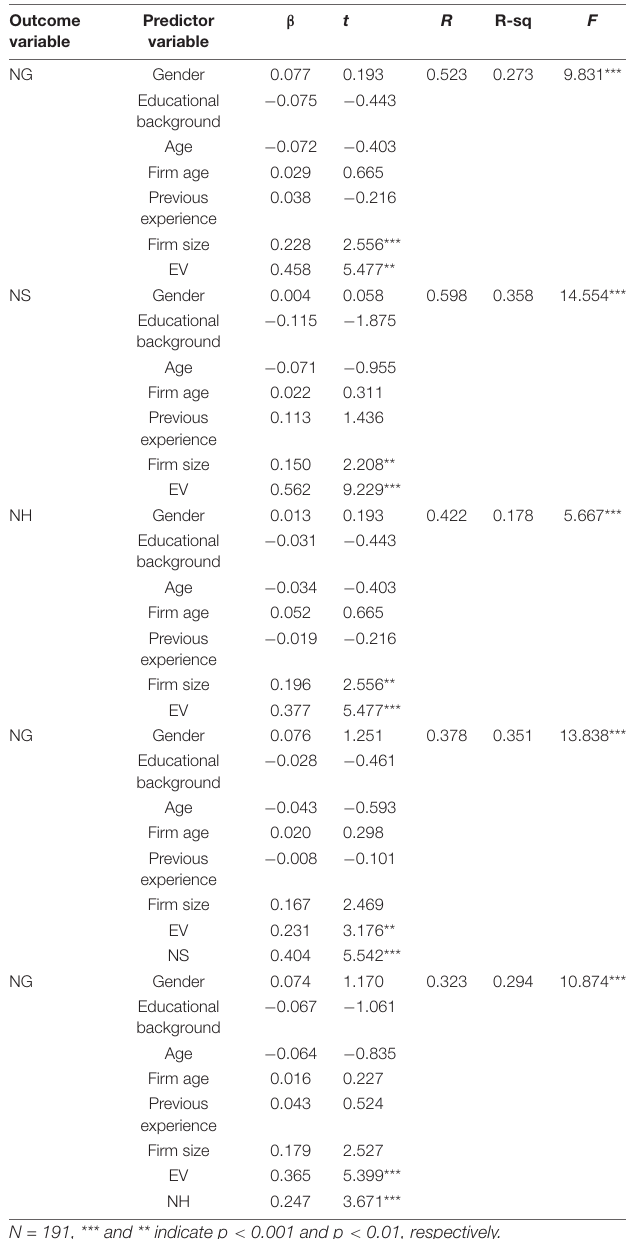
TABLE 4 | Regression analysis between